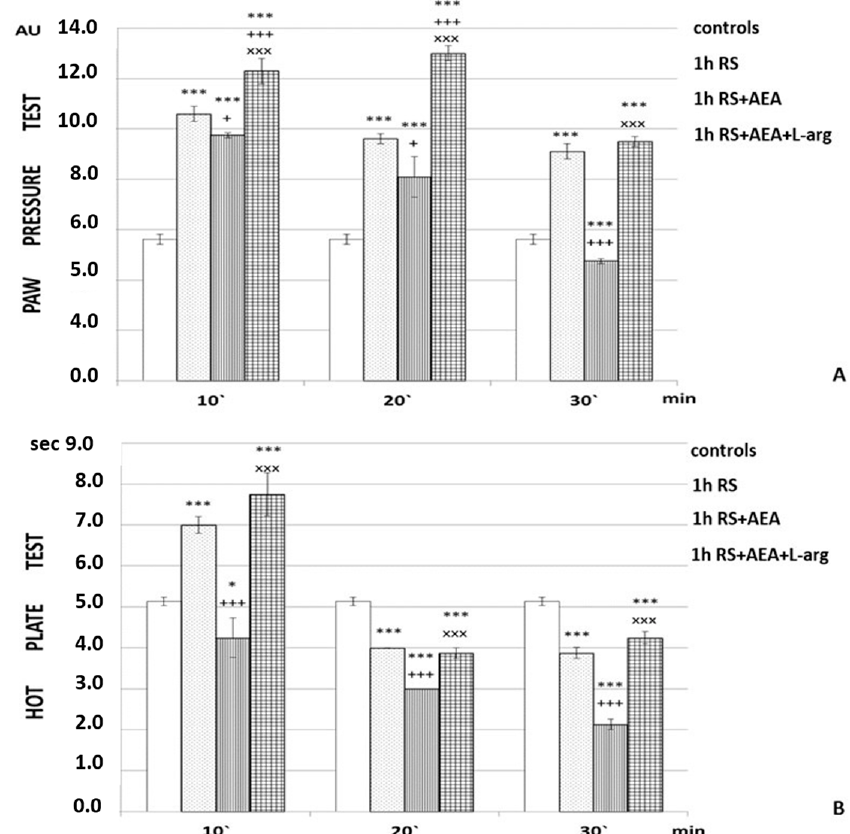
Figure 1. Effects of AEA and L-arg on r-SIA estimated by ( A ) PP test and ( B ) HP test after 1 h of restraint (1 h RS) in rats. The mean values ± SEM are presented. *** p < 0.001, * p < 0.05 vs. control; +++ p < 0.001, + p < 0.05 vs. RS; xxx p < 0.001 vs. RS + AEA; +++ p < 0.001 (F = 37.8692 at the 10th min; F = 302.4439 at the 20th min); 1 h RS + AEA group (F = 161.55249 at the 10th min; F = 609.1875 at the 20th